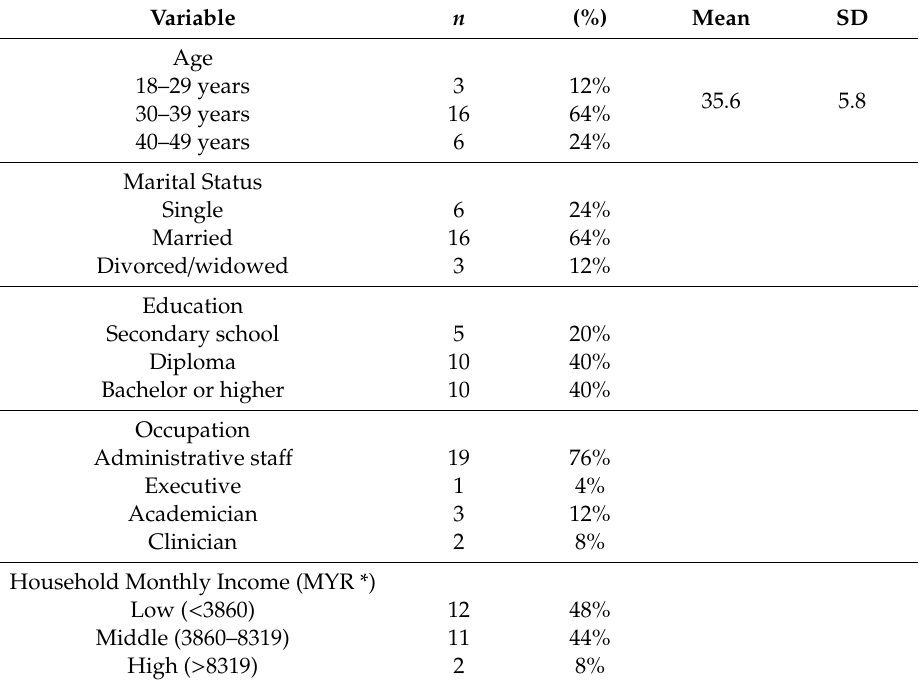
Table 2. Participants’